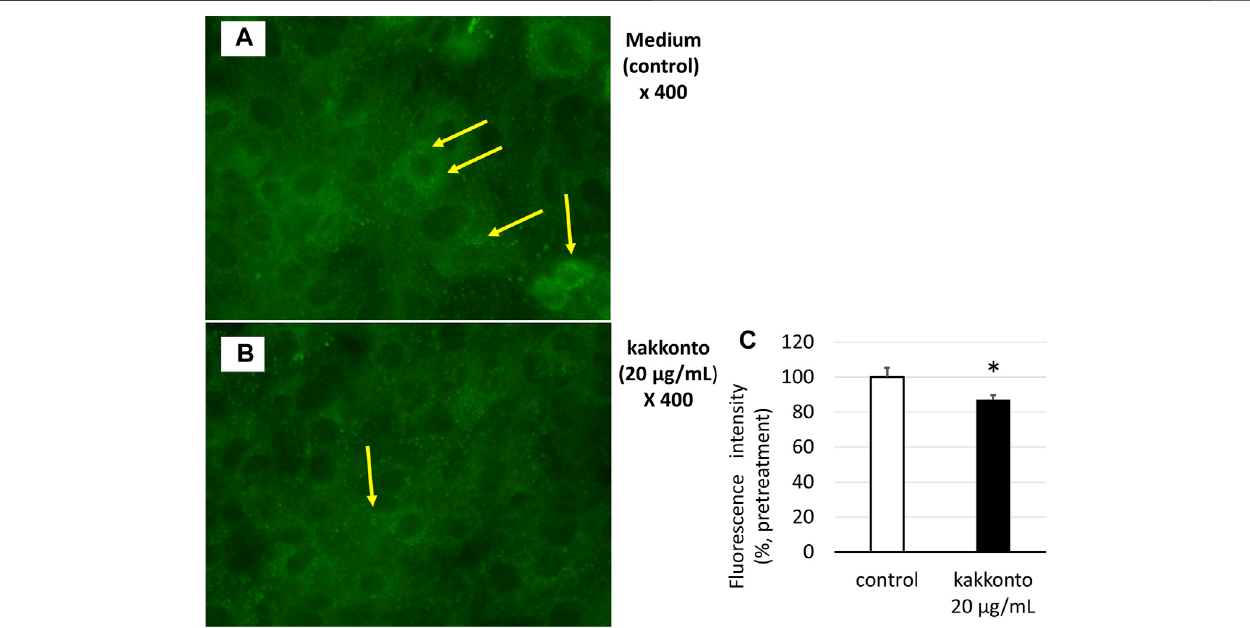
FIGURE 5 | (A,B) Distribution of acidic endosomes exhibiting green fl uorescence in HNE cells 24 h after treatment with kakkonto (20 μ g/ml) (B) or medium (A) . Yellow arrows indicate acidic endosomes in HNE cells. Data are representative of four individual experiments. Magni fi cation, × 400. (C) Fluorescence intensity of acidic endosomes in HNE cells 24 h after treatment with kakkonto (20 μ g/ml) or medium (control). The mean fl uorescence intensity of the control cells was set at 100%. * p < 0.05.